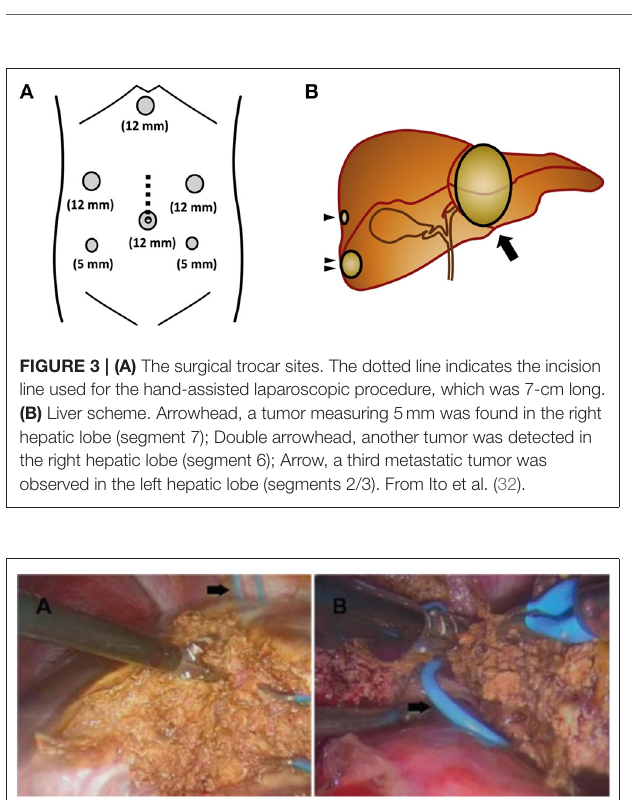
authors (9, 13). Therefore, major hepatic resections should